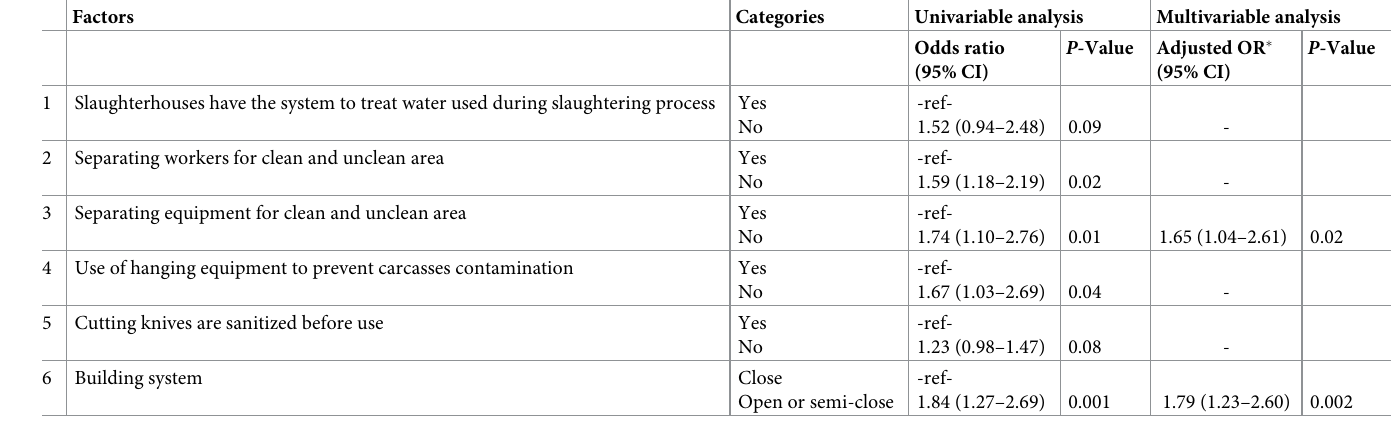
Table 7. Factors associated with the Salmonella spp. non-compliance of meat samples based on the univariable and multivariable mixed-effects logistic